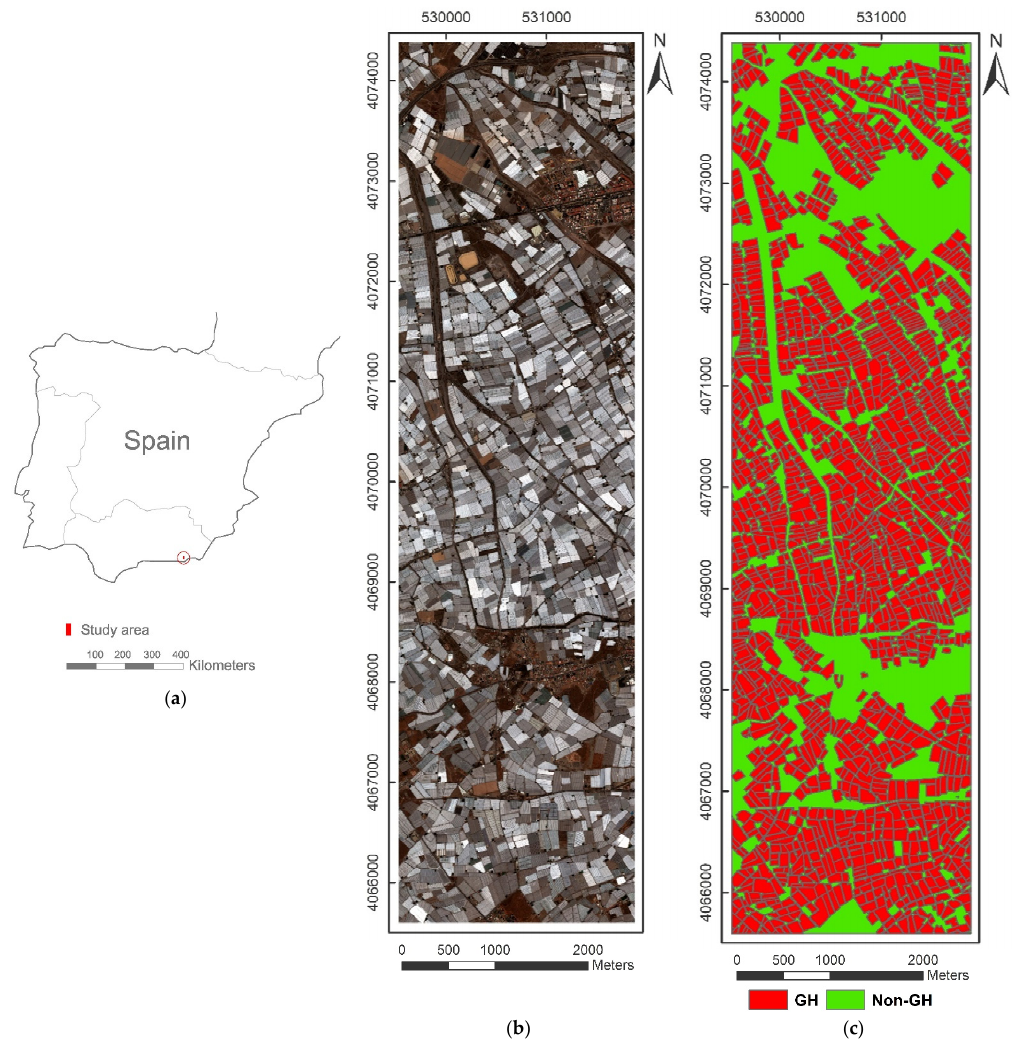
Figure 1. Location of the study area: ( a ) General situation in Spain; ( b ) RGB WorldView-3 Multispectral orthoimage; ( c ) ground truth including greenhouse class (GH) in red and non-greenhouse class (Non-GH) in green. Coordinate system: WGS84 UTM Zone 30N.